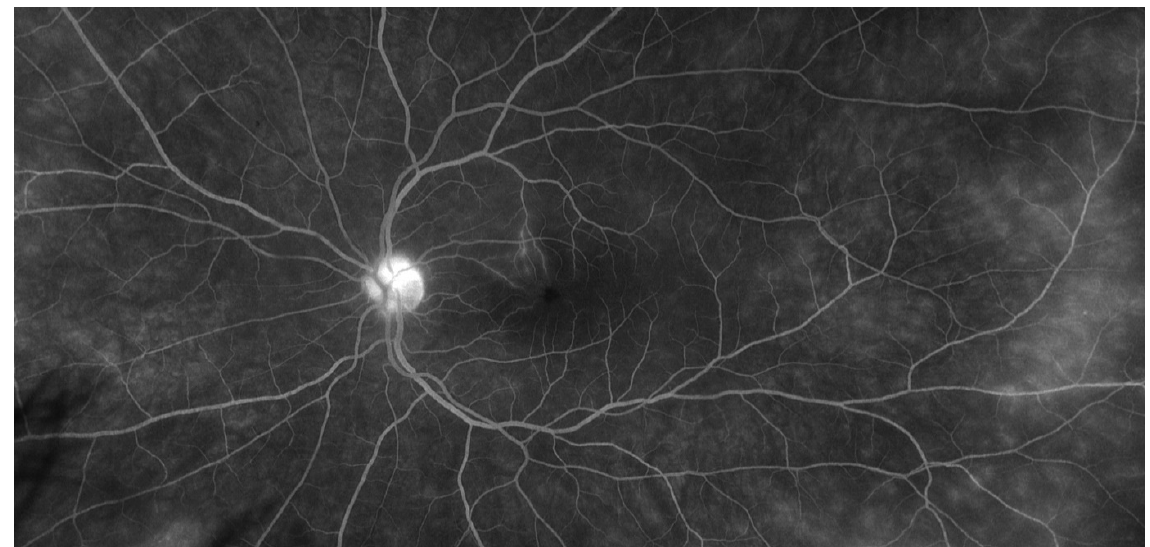
Figure 3. Late phase of ultra-wide field fluorescein angiography showing peripheral capillaropathy and vasculitis in the macular area responsible for visual acuity loss during Behçet’s disease uveitis.